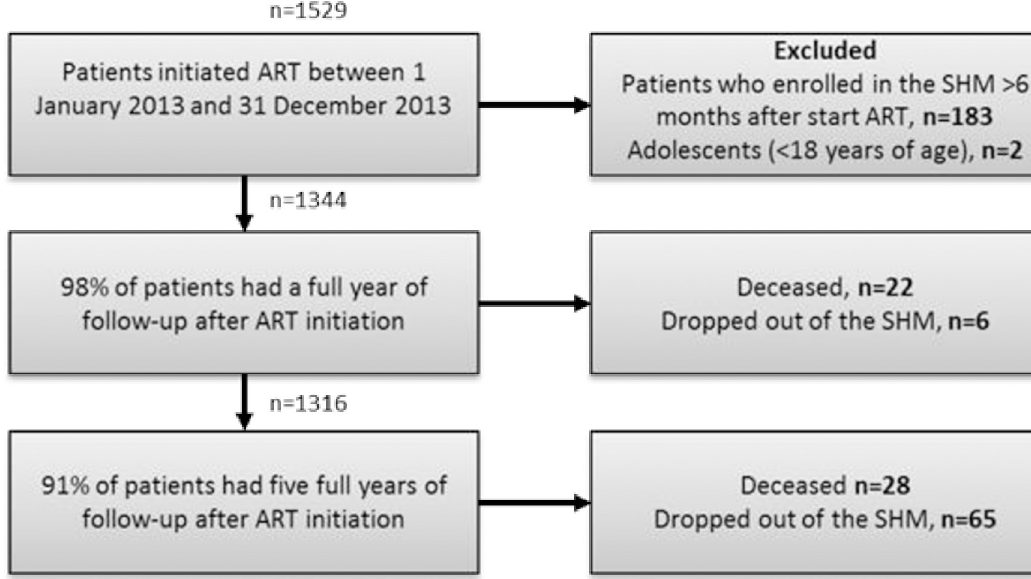
Fig 1. Flow chart of the study. 1223 PLWH remained with complete five years of follow-up data.